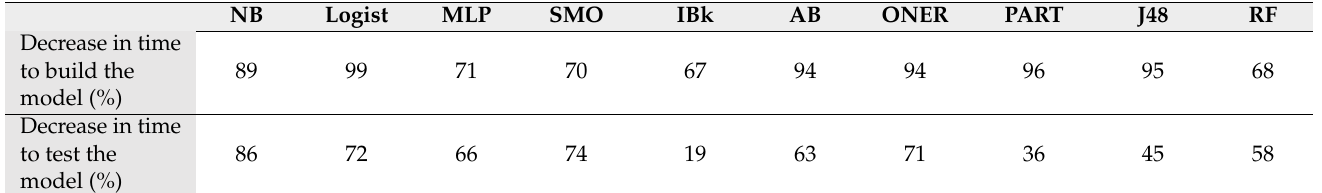
Table 16. Decrease in percentage of execution times (in training and test phases) in the Friday- Afternoon DDoS file using attributes selection.